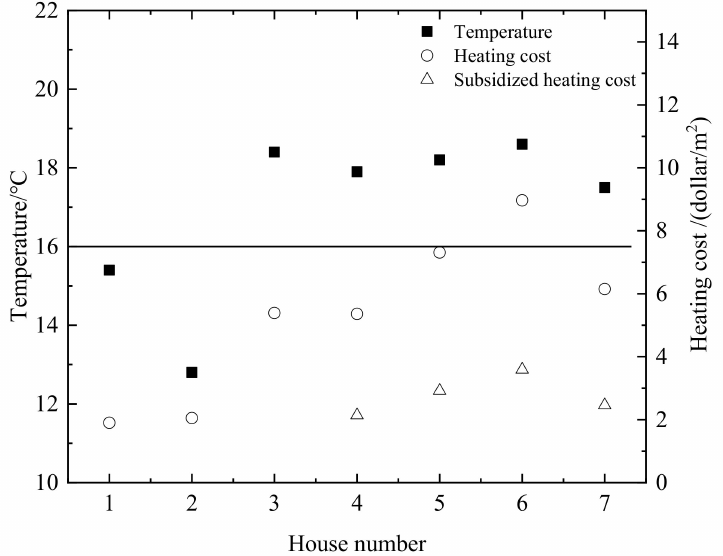
Figure 1. Indoor average temperature and annual heating costs during heating